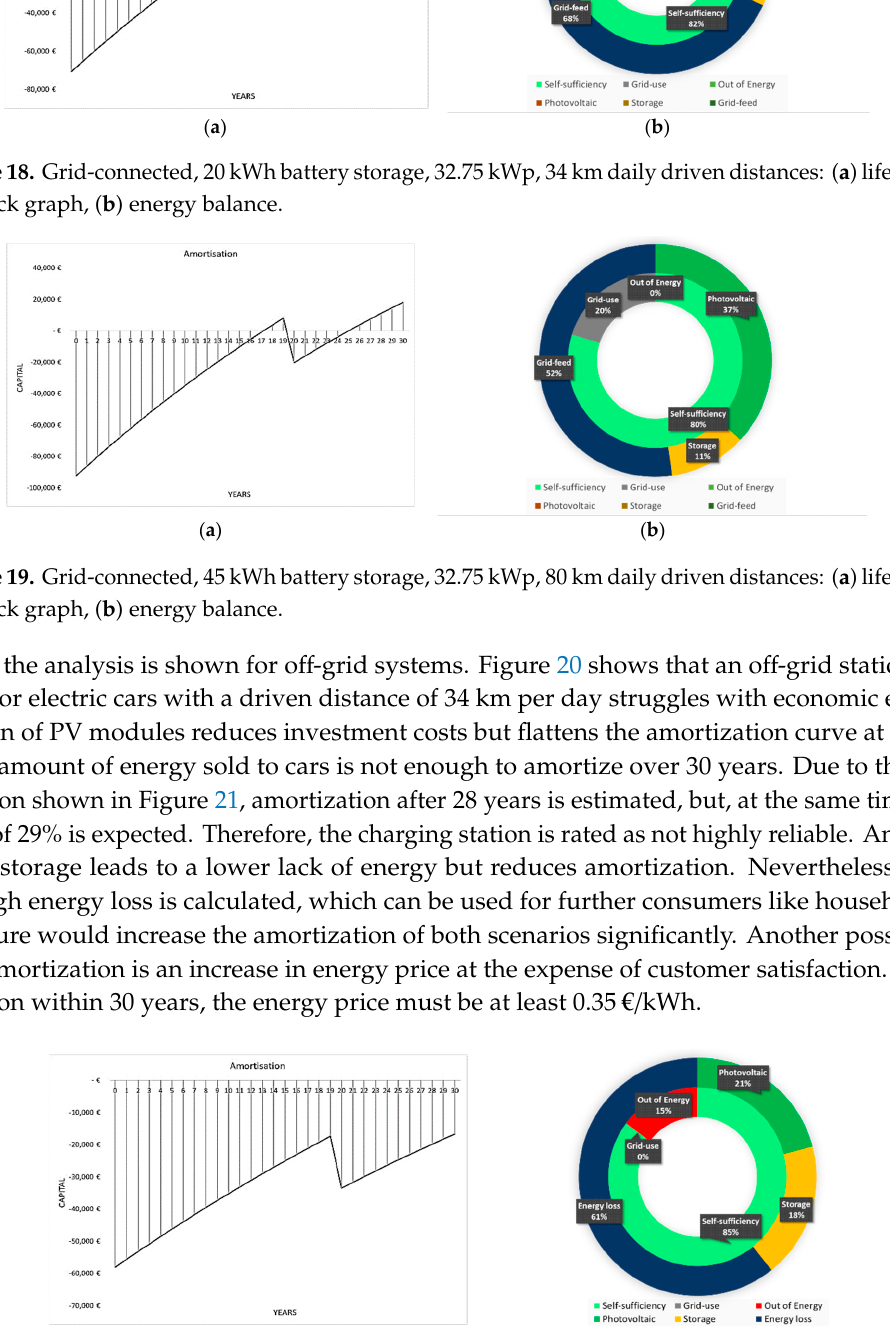
( b ) Figure 21. Off-grid, 20 kWh battery storage, 32.75 kWp, 80 km daily driven distances: ( a ) lifetime payback graph, ( b ) energy balance. 6. Conclusions Results of the analysis show that a charging station based on renewable energy sources constitutes an efficient alternative to a conventional charging station based on grid usage. By the usage of renewable energies, not only a reduction of CO 2 emissions is ensured but also a reduction in power grid usage. Especially regarding electric vehicles which may cause grid overload, charging stations preventing negative grid impact must be focused on. Trendlines show the interest in increased charging power for charging spots to shorten the charging times of EVs. Currently, so- called high-power charging spots already reach up to 350 kW and enable charging times comparable to CEVs. Such projects capture attention, although their breakthrough may endanger the current grid. This trend of charging EVs with more than 22 kW makes designing and planning charging stations even more essential to prevent grid impacts. Therefore, the tool also illustratively proves that charging EVs above 22 kW is not necessary, especially as the behavior of charging EVs is changed significantly compared to CEVs. The tool has been developed to help find solutions for each combination of charging station properties, for up to five cars, with customized proportions of renewable energies, identifying the most efficient combination. It emerges that solar charging stations for private and commercial use can be designed efficiently, although they have higher investment costs than conventional ones. Taking into account that isolated charging stations do not utilize 50% of their yield, additional consumers can reduce the period of amortization significantly. Further, results show that reduced consumption consequently flattens the amortization curve. Thus, stations should be located with high accessibility, at places with a potentially high number of electric cars or at locations with regular consumers like offices or schools. In case the charging station is located in a less trafficked area, this